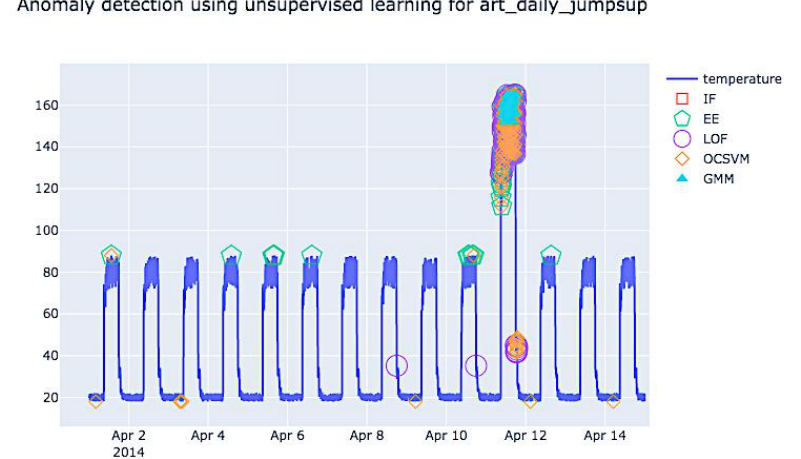
Figure 14. Visualization of novelty anomaly detection using trained unsupervised learning model for jumps up in art daily dataset from NAB.